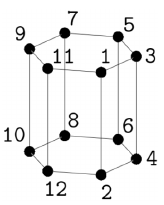
FIG. 10. Consider a circuit for measuring a v generator of Z type in which its supporting qubits are labeled as displayed above and the ordering of data CNOT gates is ( 1, 2, . . . , 12 ) . A single fault in the circuit is either v type or v ∗ type, depending on whether the data errors on the center and the bottom planes have the same form. For example, an IZ fault on the seventh data CNOT gate is a v ∗ fault since the data error arising from the fault is Z 9 Z 11 ⊗ Z 8 Z 10 Z 12 , while an IZ fault on the eighth data with CNOT gate is a v fault since the data error arising from the fault 2D + j is Z 9 Z 11 ⊗ Z 10 Z 12